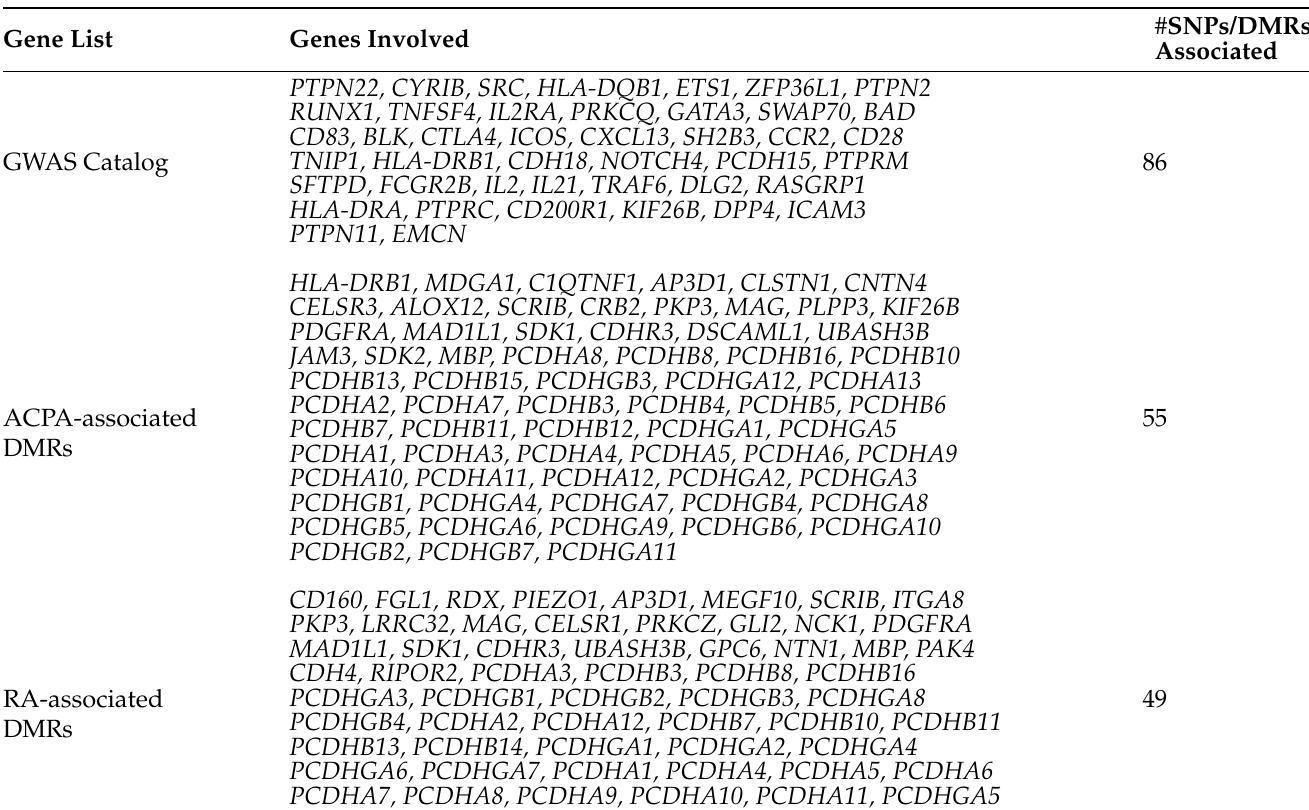
Table 7. Gene symbols involved in cell–cell adhesion (GO:0098609) for each of the profiled gene sets, with the number of associated